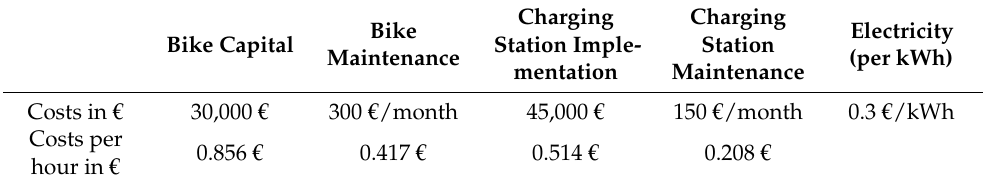
Table 5. Bike and charging station cost